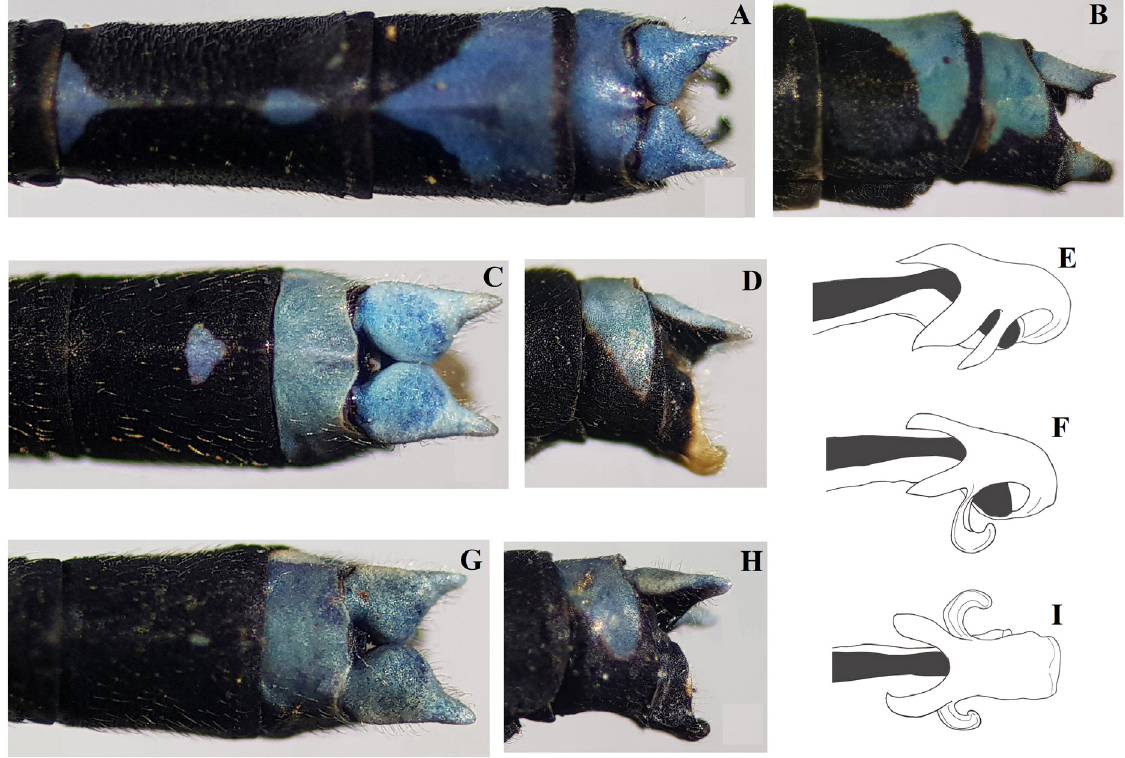
Fig. 3. Prodasineura Cowley, 1934 spp., males. A–B, E . P. coerulescens (Fraser, 1932), ZCDTU 2016100801-ODO. C–D, F . P.